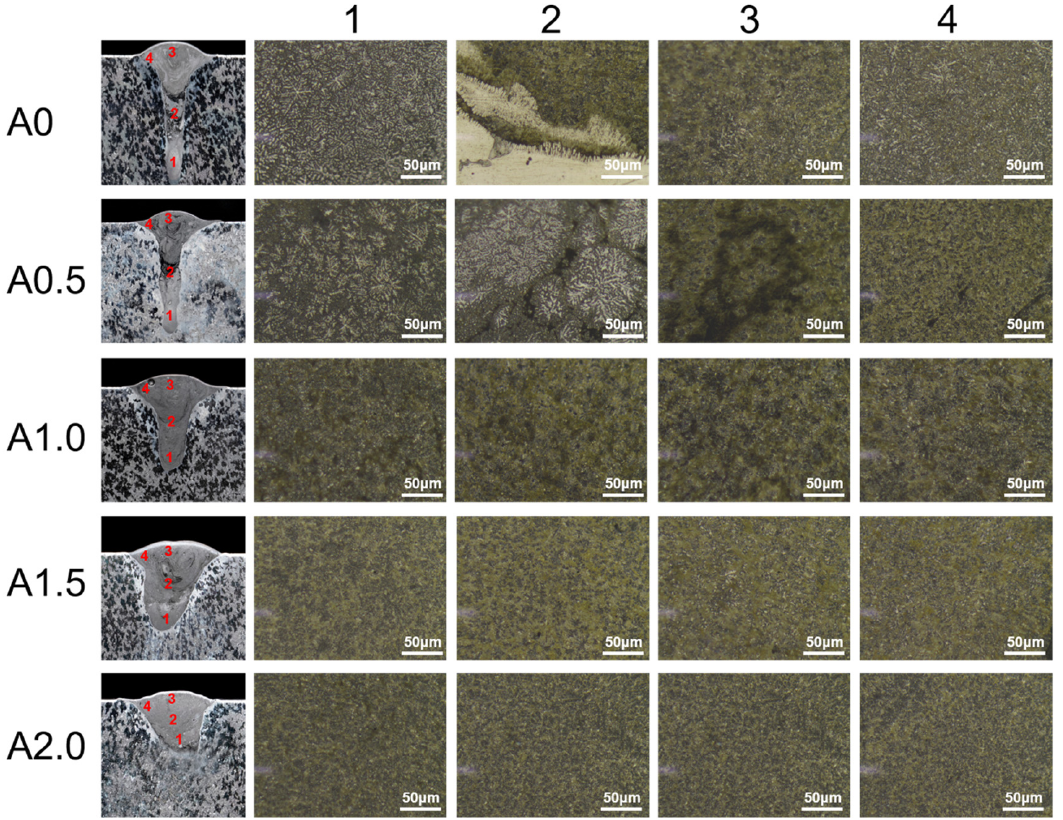
Figure 5. Optical microscope images of the cross-section profile of the weld seam cladded with different oscillating amplitudes.